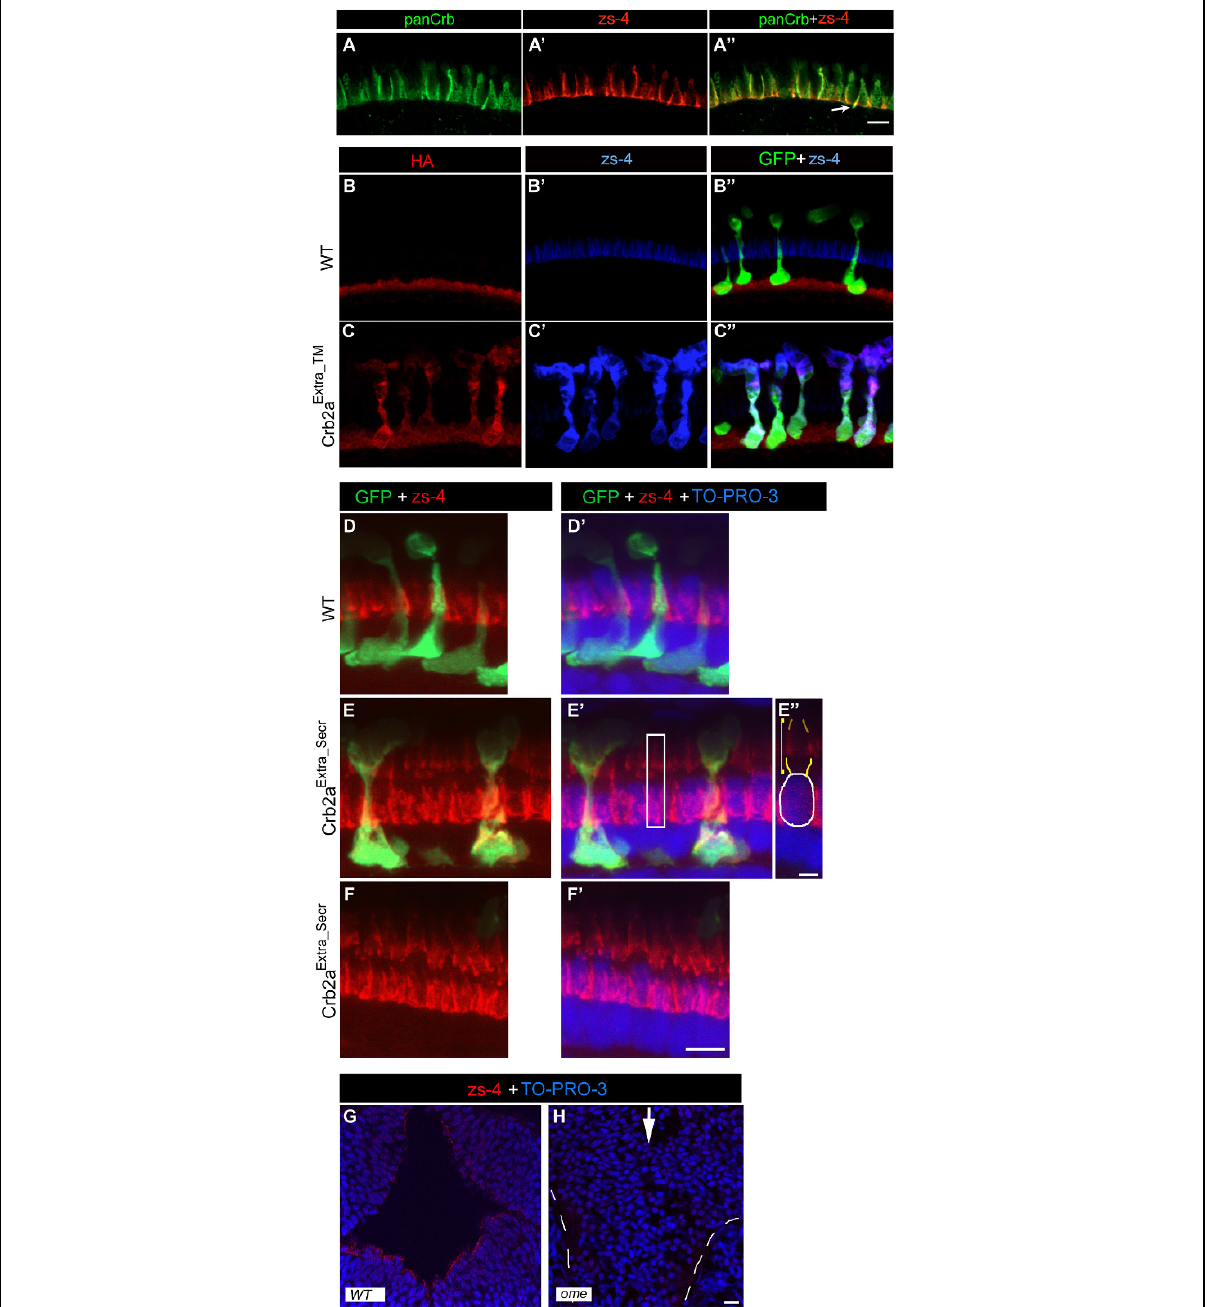
Figure 5 The zs-4 antibody recognizes the extracellular domain of Crb2a . (A-A ” ) Single confocal z-section of the photoreceptor layer in a 6 d wild-type retina labeled with rabbit panCrb antibodies (A) and zs-4 monoclonal (A ’ ) and the two channels merged (A ” ). The arrow indicates where anti-panCrb and zs-4 labeling does not appear to fully overlap. (B-C ” ) Confocal z-projection of a 6 d retina labeled with anti-HA antibody (monoclonal IgG 3 ; red) and zs-4 antibody (blue) and merged with anti-GFP (green). (B-B ” ) Wild-type retina. (C-C ” ) Crb2a Extra_TM transgenic retina. Endogenous Crb2a labeling is weak in comparison to Crb2a Extra_TM protein (C ” ). (D-F ’ ) Confocal z-projection of the photoreceptor layer in a 6 d retina labeled with zs-4 antibody (red), rods express GFP (green). TO-PRO-3 (blue) labeling reveals the position of nuclei in the photoreceptor layer. (D-D ’ ) Wild-type retina. (E-E ” ) Crb2a Extra_Secr transgenic retina. Single z-section from the white boxed area in E ’ , showing zs-4 labeling around the inner segment (indicated by yellow bracket and outlined in yellow) of a double-cone, the cell-body is circled in white (E ” ). (F-F ’ ) Crb2a Extra_Secr transgenic retina where no rods are present. (G-H) Single z-section of the brain ventricular region of a 40 hour postfertilization embryo labeled with zs-4 antibody (red) showing ventricular surface labeling. Cell nuclei are labeled with TO-PRO-3 (blue). (G) Wild-type embryo. (H) ome ( crb2a ) mutant embryo. The midline (where the ventricles would normally form) is indicated by the white arrow, and eyes indicated by dashed white lines. Scale bars, 5 μ m (A-A" ’ , D-F ’ ) 10 μ m (G,